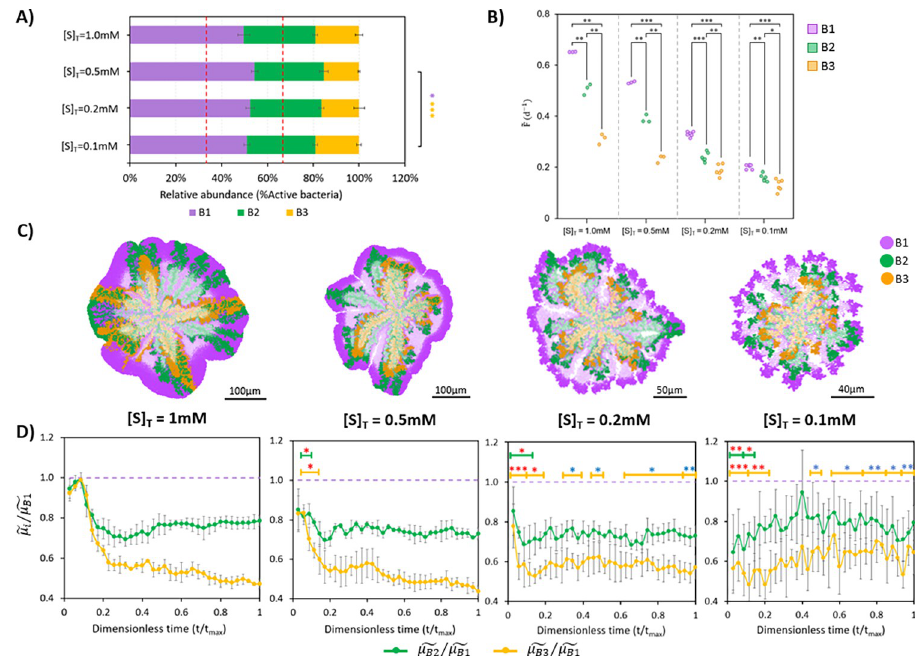
Fig 5. Commensalism [0,+,+]. (A) Relative abundances of B1, B2 and B3 populations in the community. Dashed red lines indicate 33.33% and 66.66% relative abundances. Square brackets with asterisks indicate the significance level of the difference between relative abundances between populations. Colour of asterisks points out what bacteria it refers to. (B) Microbial fitness (median, ~ F ~ ) is calculated in all replicates ( n = 3 for 1.0 mM and 0.5 mM; n = 6 for 0.2 mM and 0.1 mM). (C) Aggregates captured at steady state (50 d for 1.0 mM and 0.5 mM, 75 d for 0.2 mM and 0.1 mM). Inactive bacteria are shown in a lighter colour. Black solid lines on bottom represent the scale bars. (D) Transient change of growth rate ratios of active B2 and B3 over B1 ( ~ m 2~ = ~ m 1~ and ~ m 3~ = ~ m 1~ , respectively) in all replicates ( n = 3 for 1.0 mM B B B B and 0.5 mM; n = 6 for 0.2 mM and 0.1 mM). Growth rate ratios, normalise the comparison and reduce the influence of substrate concentration in the analysis. Dimensionless time was applied to compare simulations with different time length (t max ). Asterisks indicate the significance level of difference between 1.0 mM and the other concentrations (1.0 mM vs 0.5 mM; 1.0 mM vs 0.2 mM; 1.0 mM vs 0.1 mM). Colour of asterisks: red–growth rate ratio at [S] is lower than that at 1.0 mM; blue–growth rate ratio at [S] is higher than that at 1.0 mM. Significance level legend: ns, not significant; � , p < 0.05; �� , p < 0.01; ��� , p < 0.001. Width of the lines indicate the time to which the significance level corresponds. Colour of the lines: green–B2;